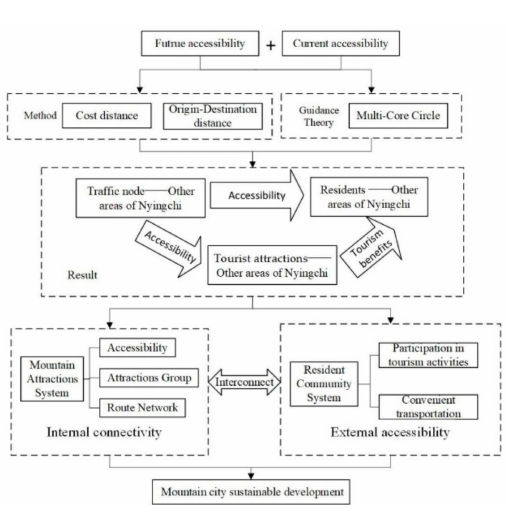
Figure 2. Framework for this